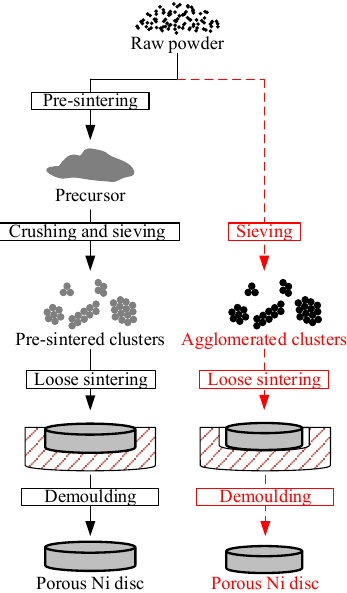
Figure 2. Schematic illustration of the experimental procedure.